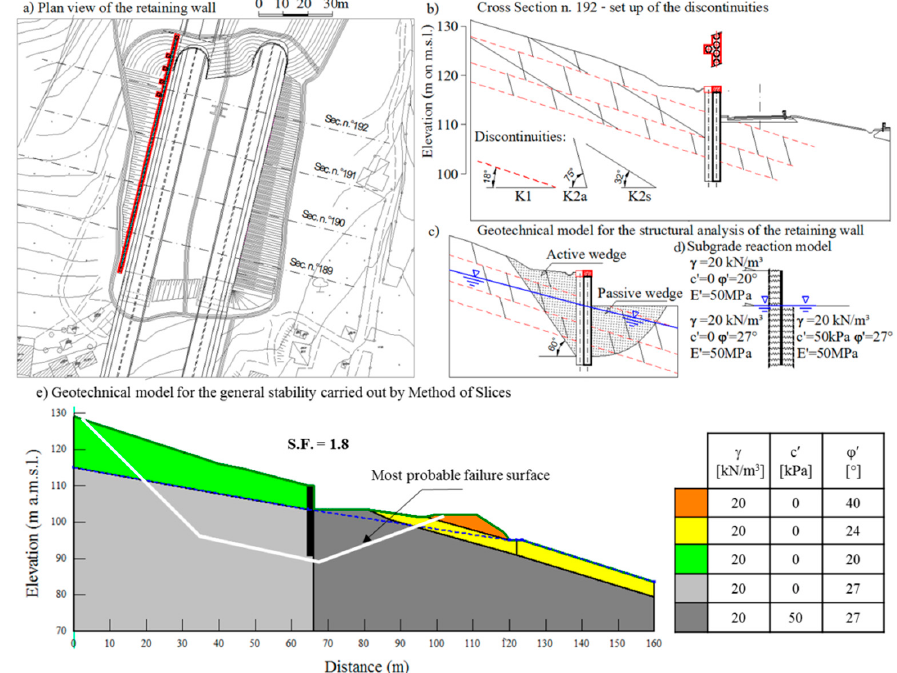
Figure 9. ( a ) Plan view of the area of interest with the position of the retaining wall; ( b ) cross-section n. 192 with the pattern of the main families of discontinuities; ( c ) geotechnical model for the structural analysis of the retaining wall (compare the pattern of discontinuities with active and passive wedge); ( d ) subgrade reaction model used to design the retaining wall (note the di ff erent strength parameters adopted to take into account the discontinuities); ( e ) geotechnical model adopted for general stability of the retaining